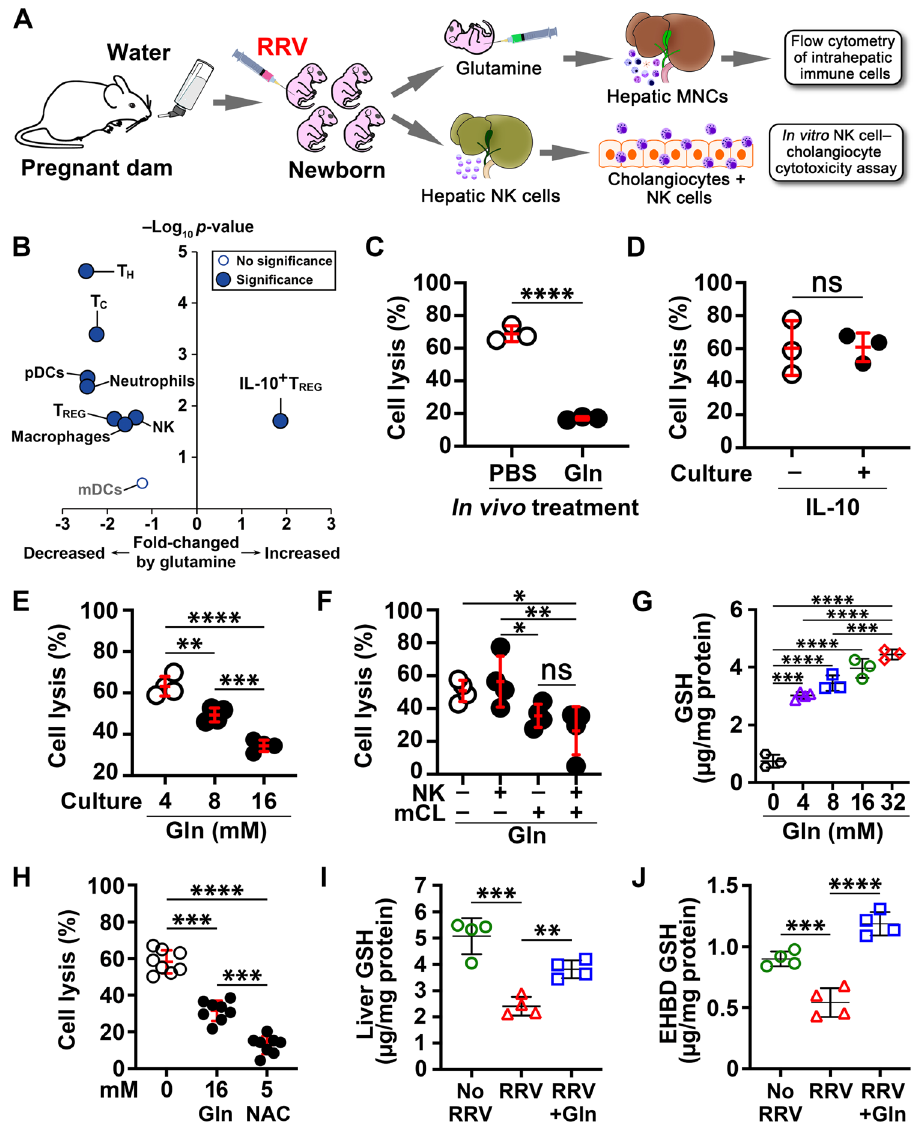
Fig. 7 Glutamine suppresses hepatic immune cells and promotes cholangiocyte resistance to NK cell-mediated lysis. A Diagrammatic representation of hepatic mononuclear cell fl ow cytometry and in vitro NK cell-mediated cholangiotoxicity assay. B Volcano plot illustrating hepatic immune cells with p values and fold changes between phosphate-buffered saline (PBS)- and glutamine-injected neonatal mice 7 days after RRV injection. The replicate values were determined using biologically distinct samples and p values calculated using unpaired Student ’ s t test with two-tailed distribution. The gating strategy for fl ow cytometric analyses is shown in Fig. S10A – K. C Percent lysis of cholangiocytes after co-culture with RRV-primed hepatic NK cells from PBS ( n = 3) or glutamine ( n = 3) injected neonatal mice and a murine cholangiocyte cell line or D in the presence ( n = 3) or absence ( n = 3) of 30 ng/ml of IL-10 (mean ± SD, unpaired Student ’ s t test with two-tailed distribution; **** p < 0.0001, ns = not signi fi cant). Assay of cholangiocyte lysis by RRV-primed NK cells co-cultured with increasing concentrations of glutamine ( n = 4 per group) ( E ), or F when individual cell type is preincubated with glutamine ( n = 4 per group; mean ± SD, two-tailed ANOVA with Duncan ’ s multiple comparison; * p < 0.05, ** p < 0.01, *** p < 0.001, **** p < 0.0001, ns = not signi fi cant). G shows total GSH levels measured in cholangiocytes after incubation with various concentrations of glutamine ( n = 3 – 4 per group; mean ± SD, two-tailed ANOVA with Duncan ’ s multiple comparison; *** p < 0.001, **** p < 0.0001). H NK cell-mediated cholangiocyte lysis in the presence of glutamine ( n = 8; 2 technical replicates and 4 biological replicates) and N -acetyl cysteine (NAC) ( n = 8, 2 technical replicates and 4 biological replicates; mean ± SD, two- tailed ANOVA with Duncan ’ s multiple comparison; *** p < 0.001, **** p < 0.0001). I Total GSH levels measured in supernatants of livers ( n = 4 biological replicates per group) and J extrahepatic bile ducts ( n = 4 biological replicates per group) from control and RRV-infected neonatal mice with or without glutamine treatment (mean ± SD, two-tailed ANOVA with Duncan ’ s multiple comparison; ** p < 0.01, *** p < 0.001, **** p < 0.0001). Source data for this fi gure are provided as a Source data fi